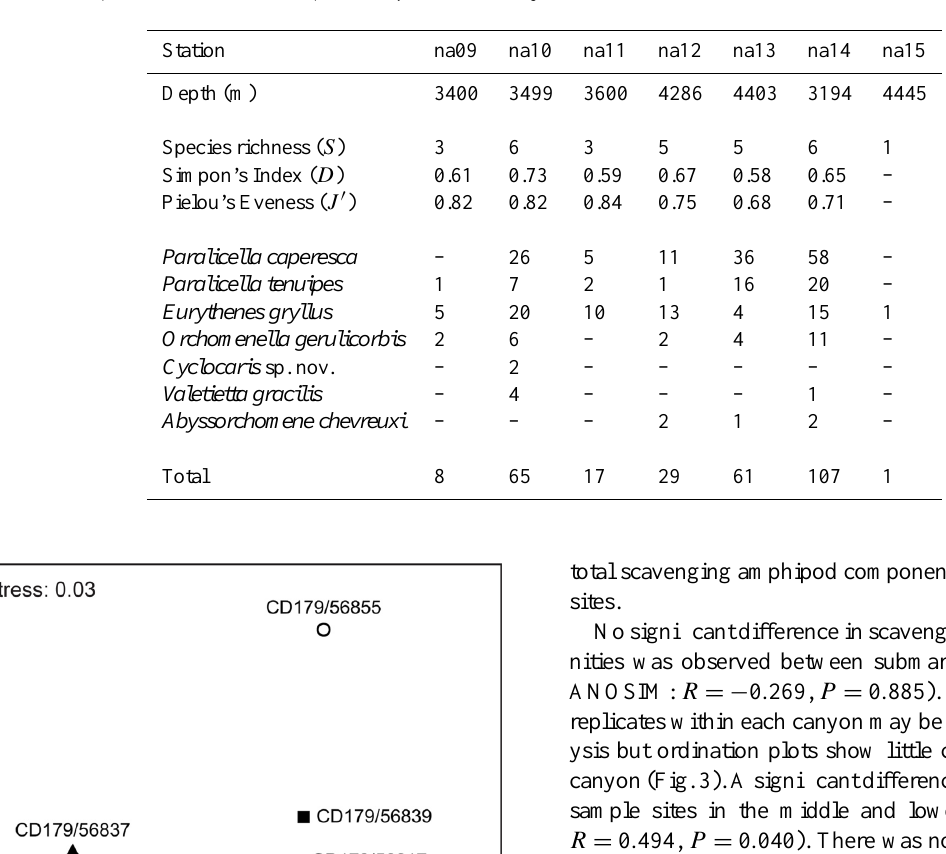
Table 2. Species composition and abundance for scavenging amphipod samples collected from baited trap deployments made on the abyssal plains adjacent to the Iberian Margin submarine canyons as part of the 1981 ABYPLANE research expedition. Taken from Thurston, 1990. Species richness ( S ), Pielous’s Eveness ( J 0 ), and Simpson’s Diversity Index ( D ) shown.